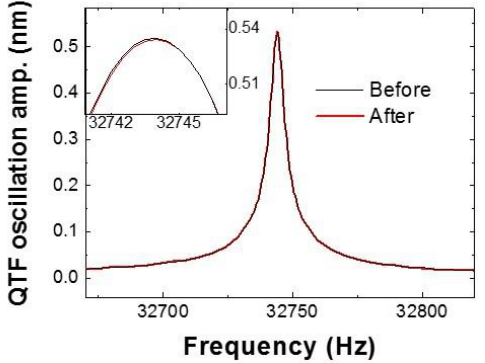
Figure 5. Reliability and durability of the buckling cantilever: We measured the resonance curves of the sensor before and after 100 oscillations. Both resonance frequencies are almost identical, at the center frequency of 32,748 Hz with a shift of ~10 − 4 Hz, and both Q -factors are 10,520, which indicates tip wear of ~10 − 4 % with the boundary of the diameter of the tip apex, thus 10 7 oscillation gives no noticeable wear.